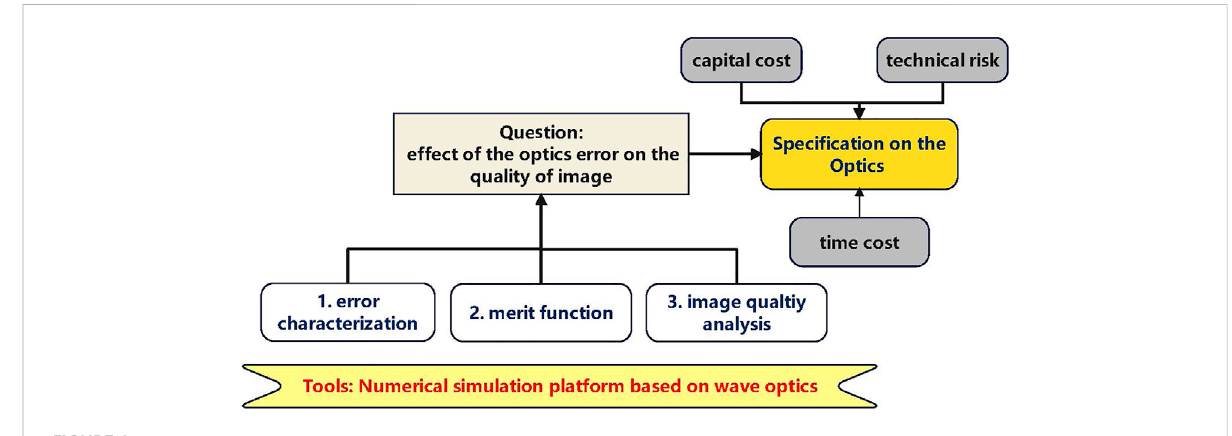
FIGURE 1 Issues related to the optics error problem.